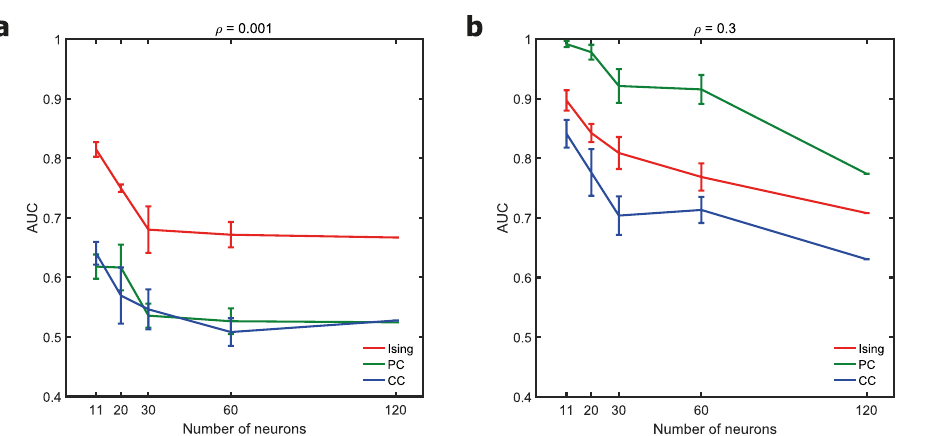
Figure 4. Effect of network size. Plot of the AUC values for networks of various sizes for a fixed firing rate of 20 Hz and correlation levels of 0.001 and 0.3 are displayed in the left panel ( a ) and the right panel ( b ) respectively. The mean value was calculated from ten networks for all cases except for networks of 120 nodes in which case the data is from the simulation of a single